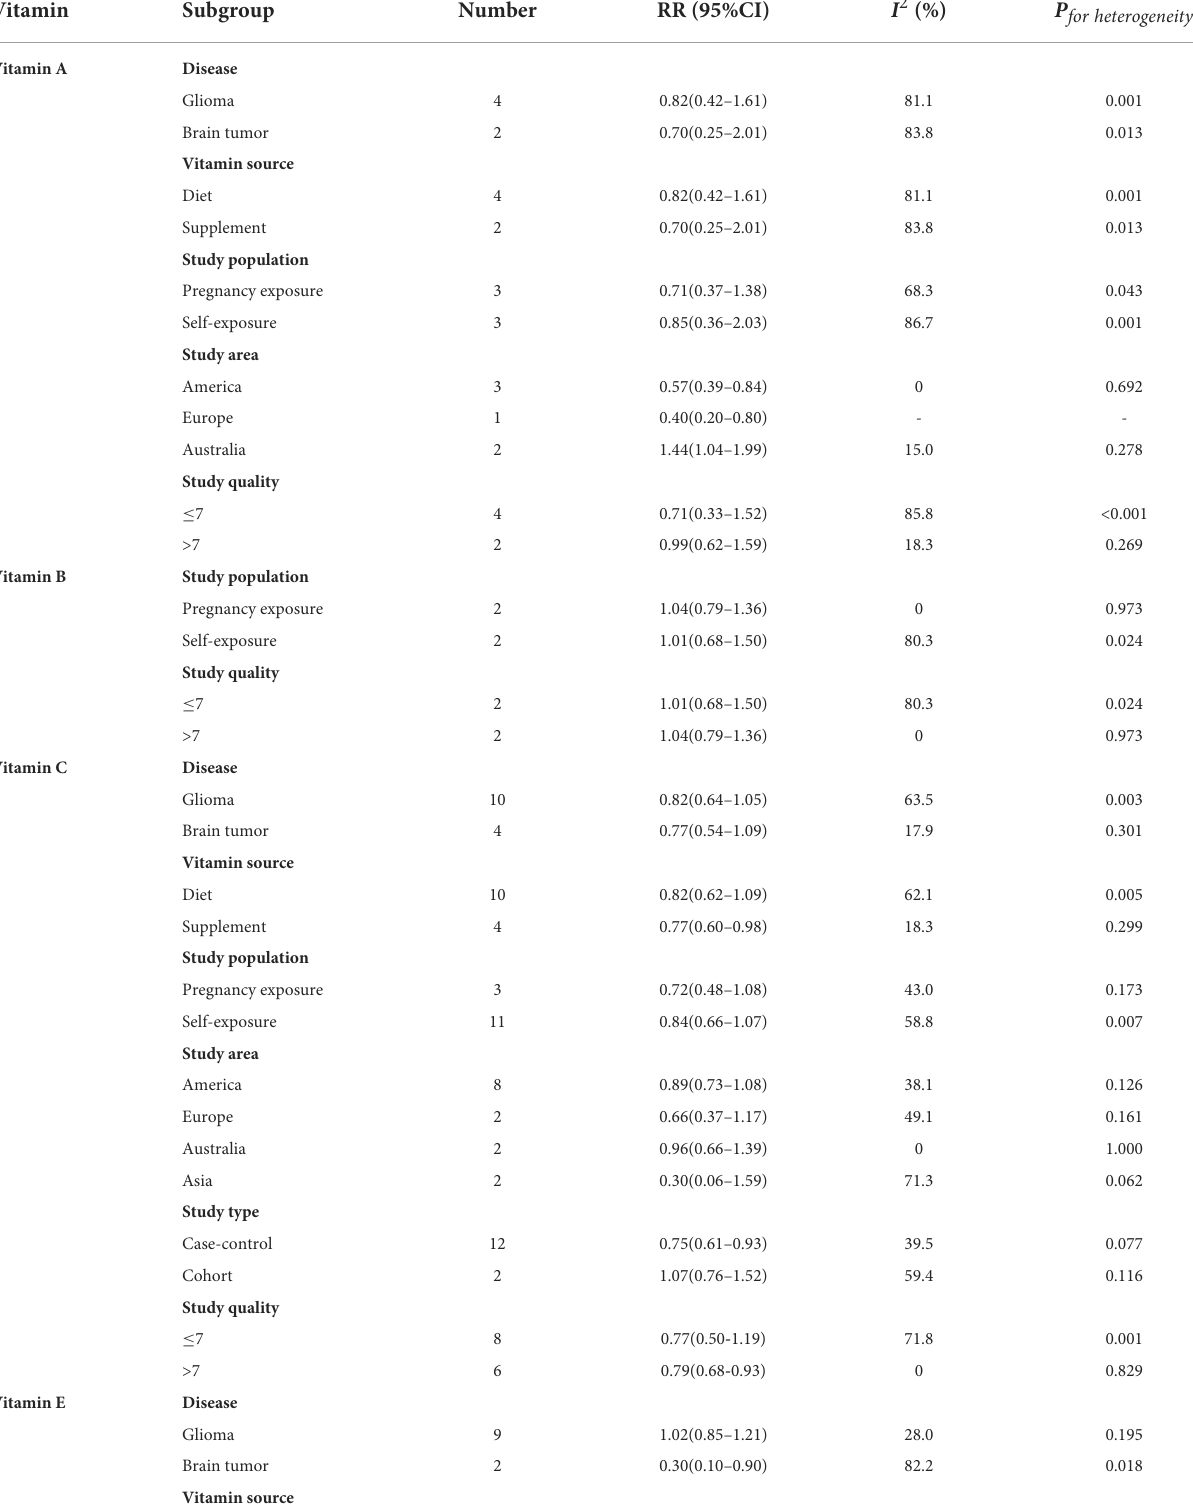
TABLE 3 Subgroup analysis for the association between vitamins and brain